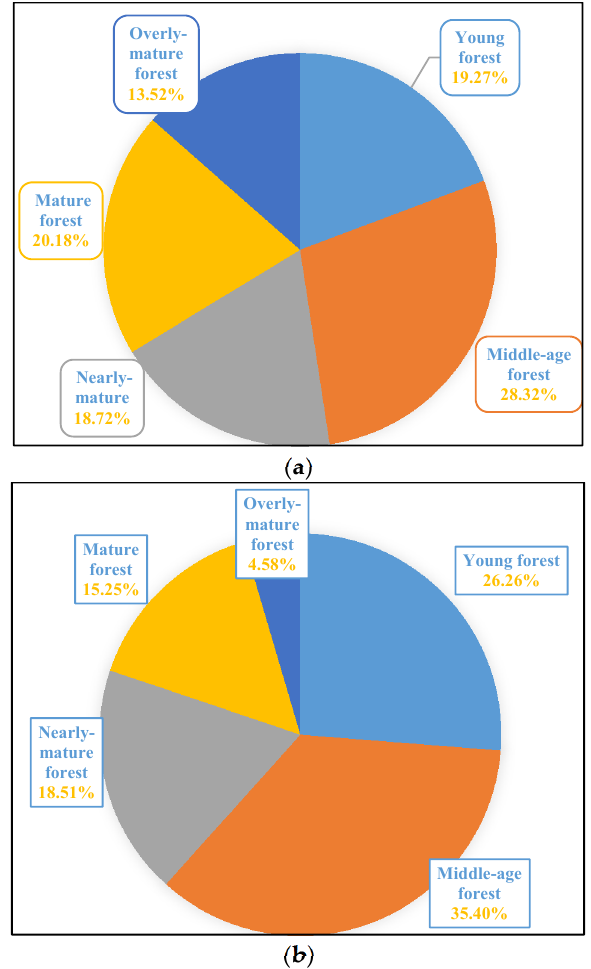
Figure 1. ( a ) Total natural forest carbon stores by age group; ( b ) Total forest plantation carbon stores by age group.